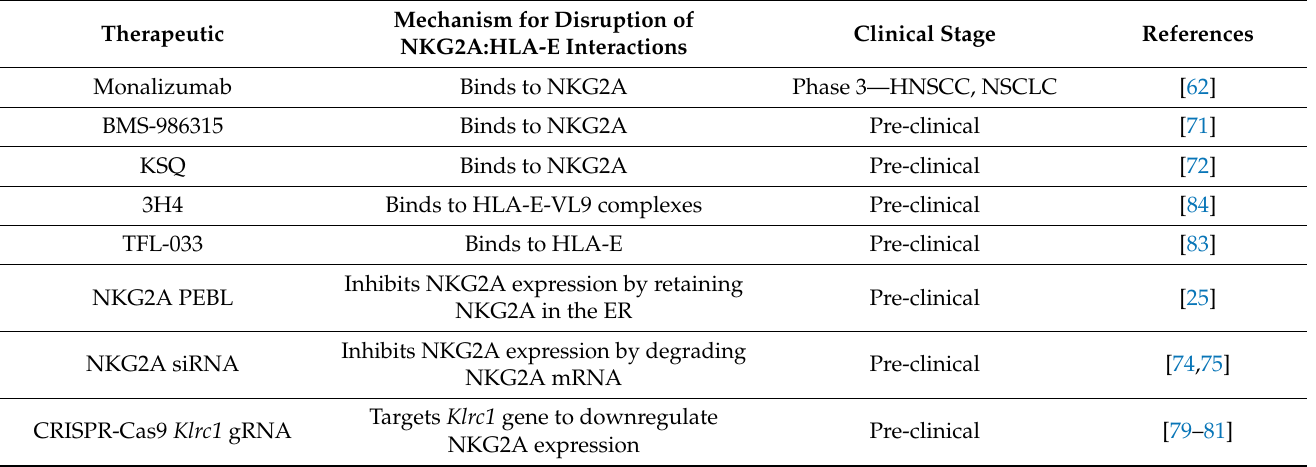
Table 1. Direct targeting of